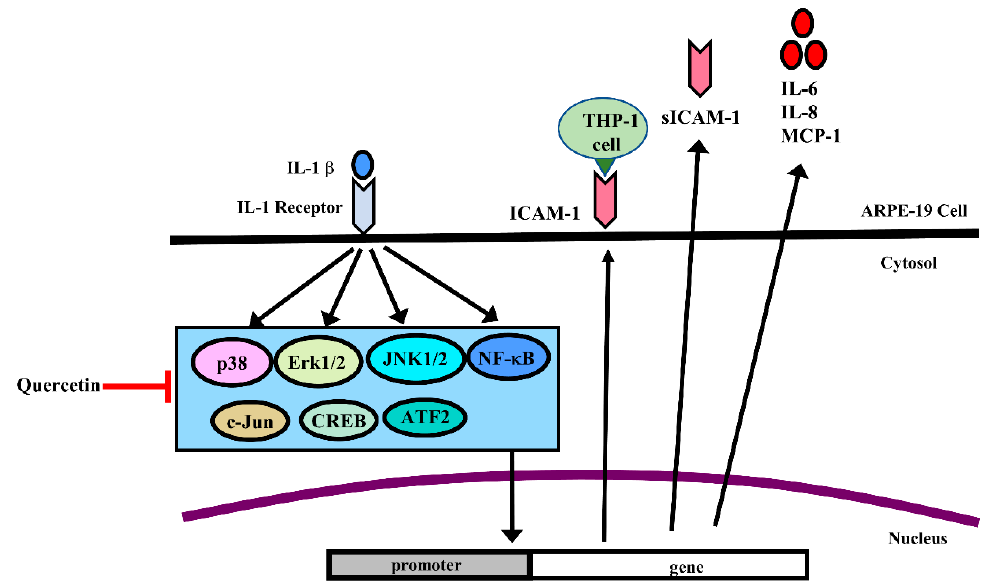
Figure 10. Schematic diagram of the signaling pathways involved in attenuation of IL-1 β -induced inflammation by quercetin via downregulation of ICAM-1, sICAM-1, IL-6, IL-8 and MCP-1 expression in ARPE-19 cells. Quercetin attenuated ICAM-1, sICAM-1, IL-6, IL-8 and MCP-1 expression via the MAPK or NF- κ B pathways in IL-1 β -stimulated ARPE-19 cells.